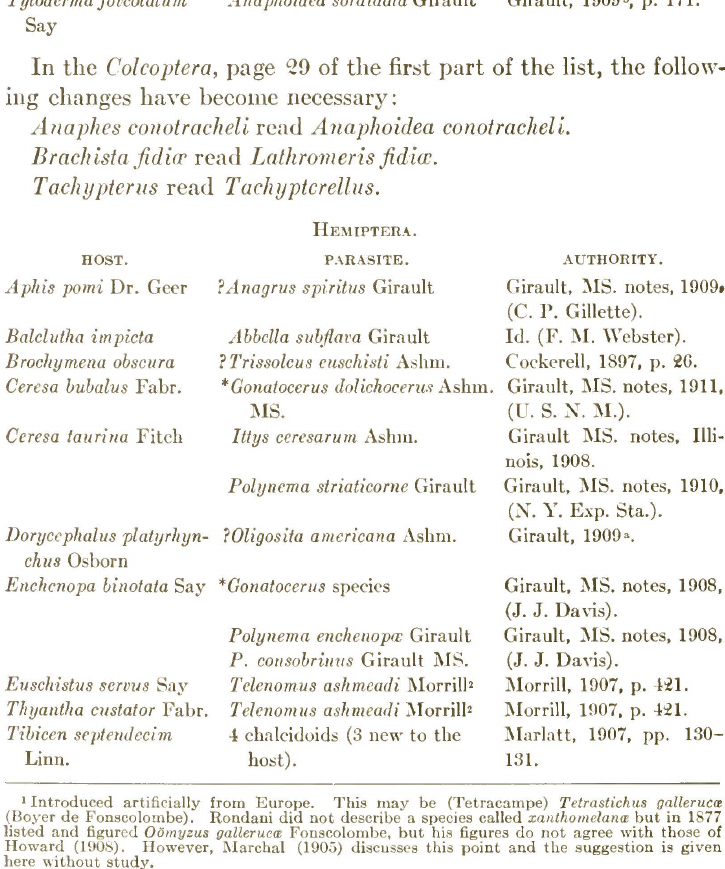
fig. 7. Marlatt, 1908, p. 4. Girault, 1909b, p.